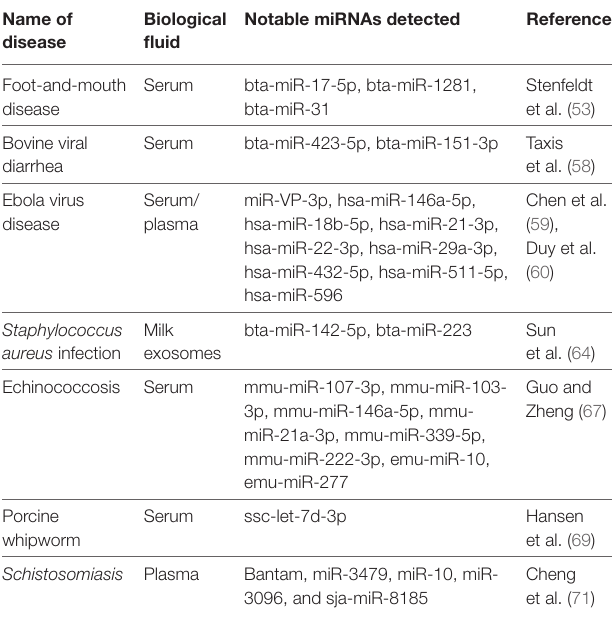
TABLe 1 | Circulating microRNAs (miRNAs) profiled in selected studies of veterinary infectious diseases. Name of